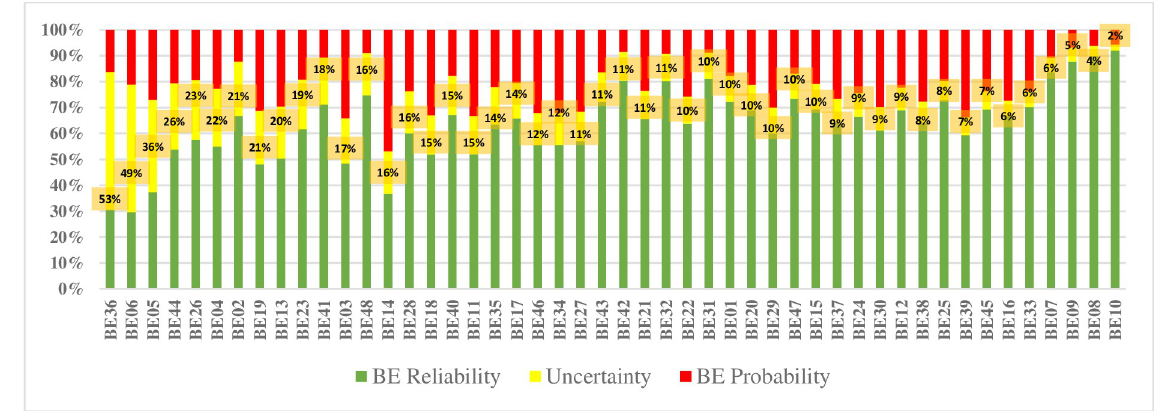
Fig 4. The connection number related to uncertainty of